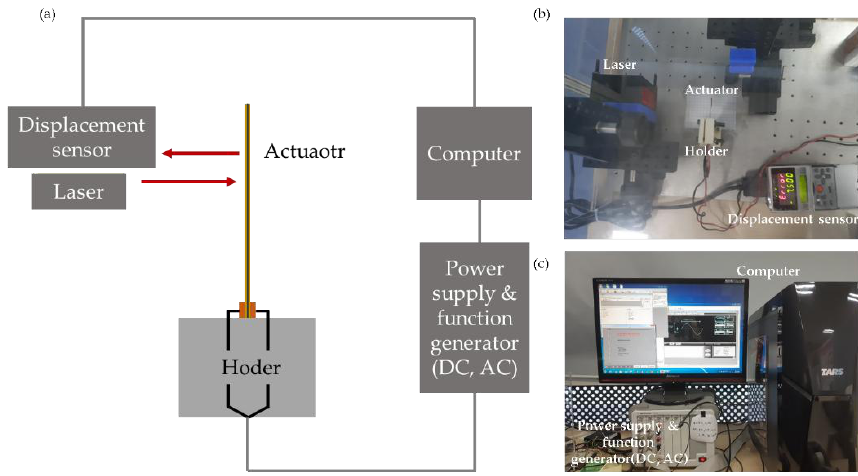
Figure 1. ( a ) Schematic diagram, and ( b , c ) photographs of actuation measurement system.